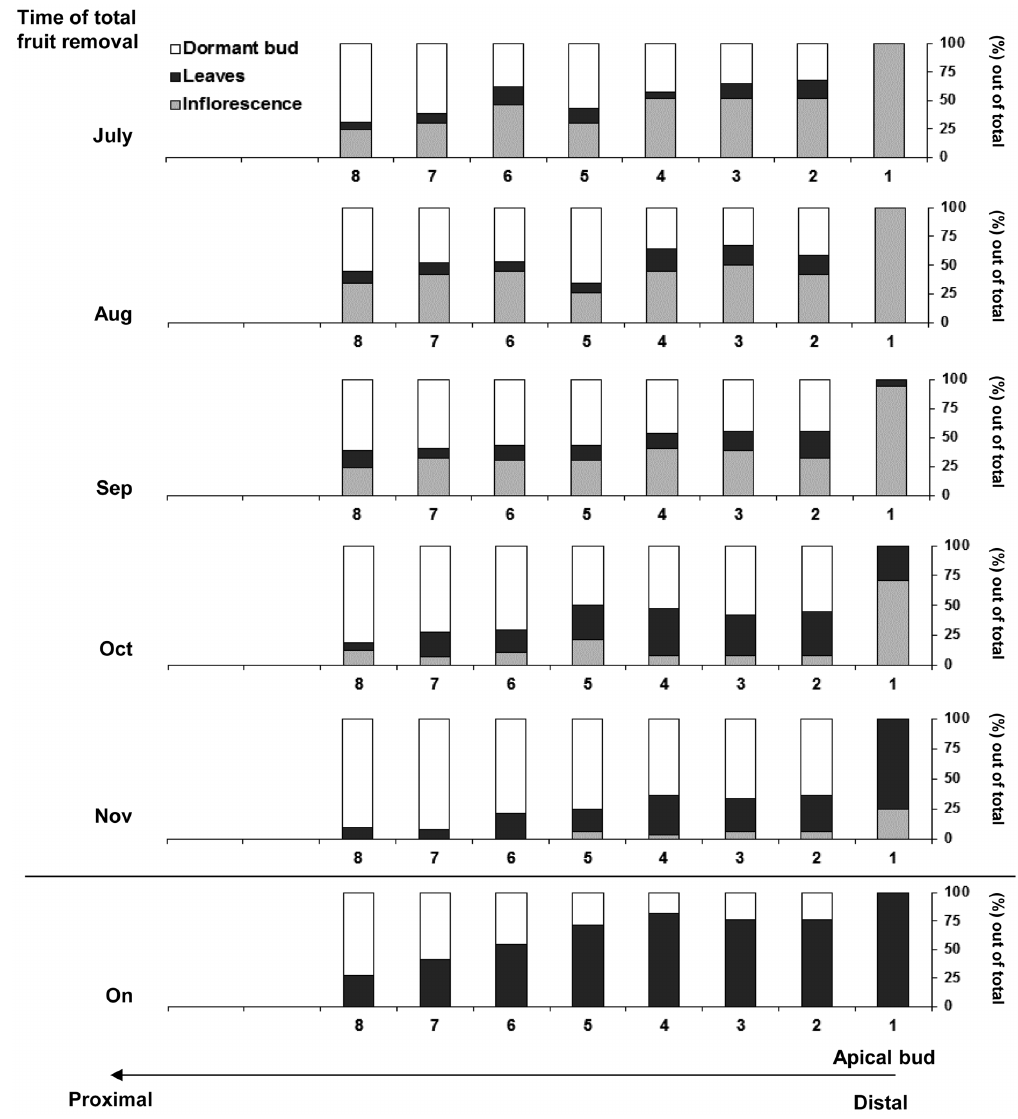
Figure 3. Effect of fruit load on inflorescence development. Complete fruit removal treatments, starting in July, 2011, were performed as described in the legend to Fig. 1. The reproductive fates of individual buds on treated (de-fruited) and untreated ( on ) trees borne along summer- growing shoots were mapped at the end of the flowering period (May, 2012). Values are expressed as percentage of dormant buds, leaves or inflorescences out of 40 records (of 10 shoots per tree) collected per treatment.